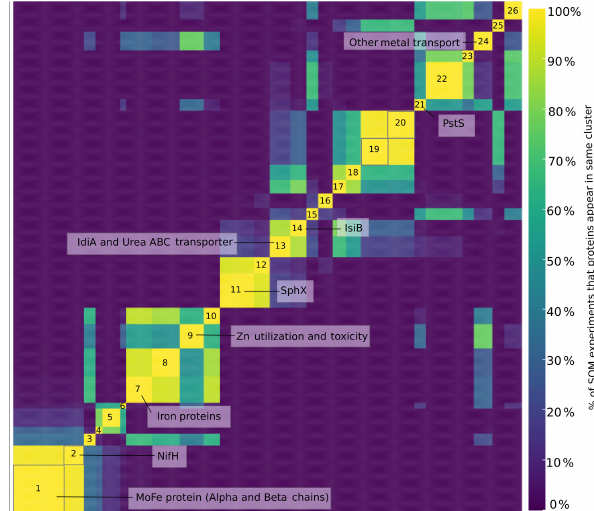
Figure 2. Heatmap displaying results of self-organizing map (SOM) analysis. Each protein was mapped to a self-organizing map grid, and the grids subsequently clustered by a k -means cluster- ing algorithm. The process was repeated 10000 times, and the re- sults are displayed here as a heatmap with warm colors represent- ing proteins that appear in the same cluster. The color bar indicates the percent of SOM experiments in which two proteins appear in the same cluster. Only the top 500 most abundant proteins are dis- played. Dark yellow indicates proteins that appear in the same clus- ter 99.99% of the time. Clusters 1 and 2 contain nitrogen fixation, carbon fixation, and nitrogen assimilation proteins, as well as the regulatory systems NtcA and P-II. The cluster assignments for the proteins are available in Table